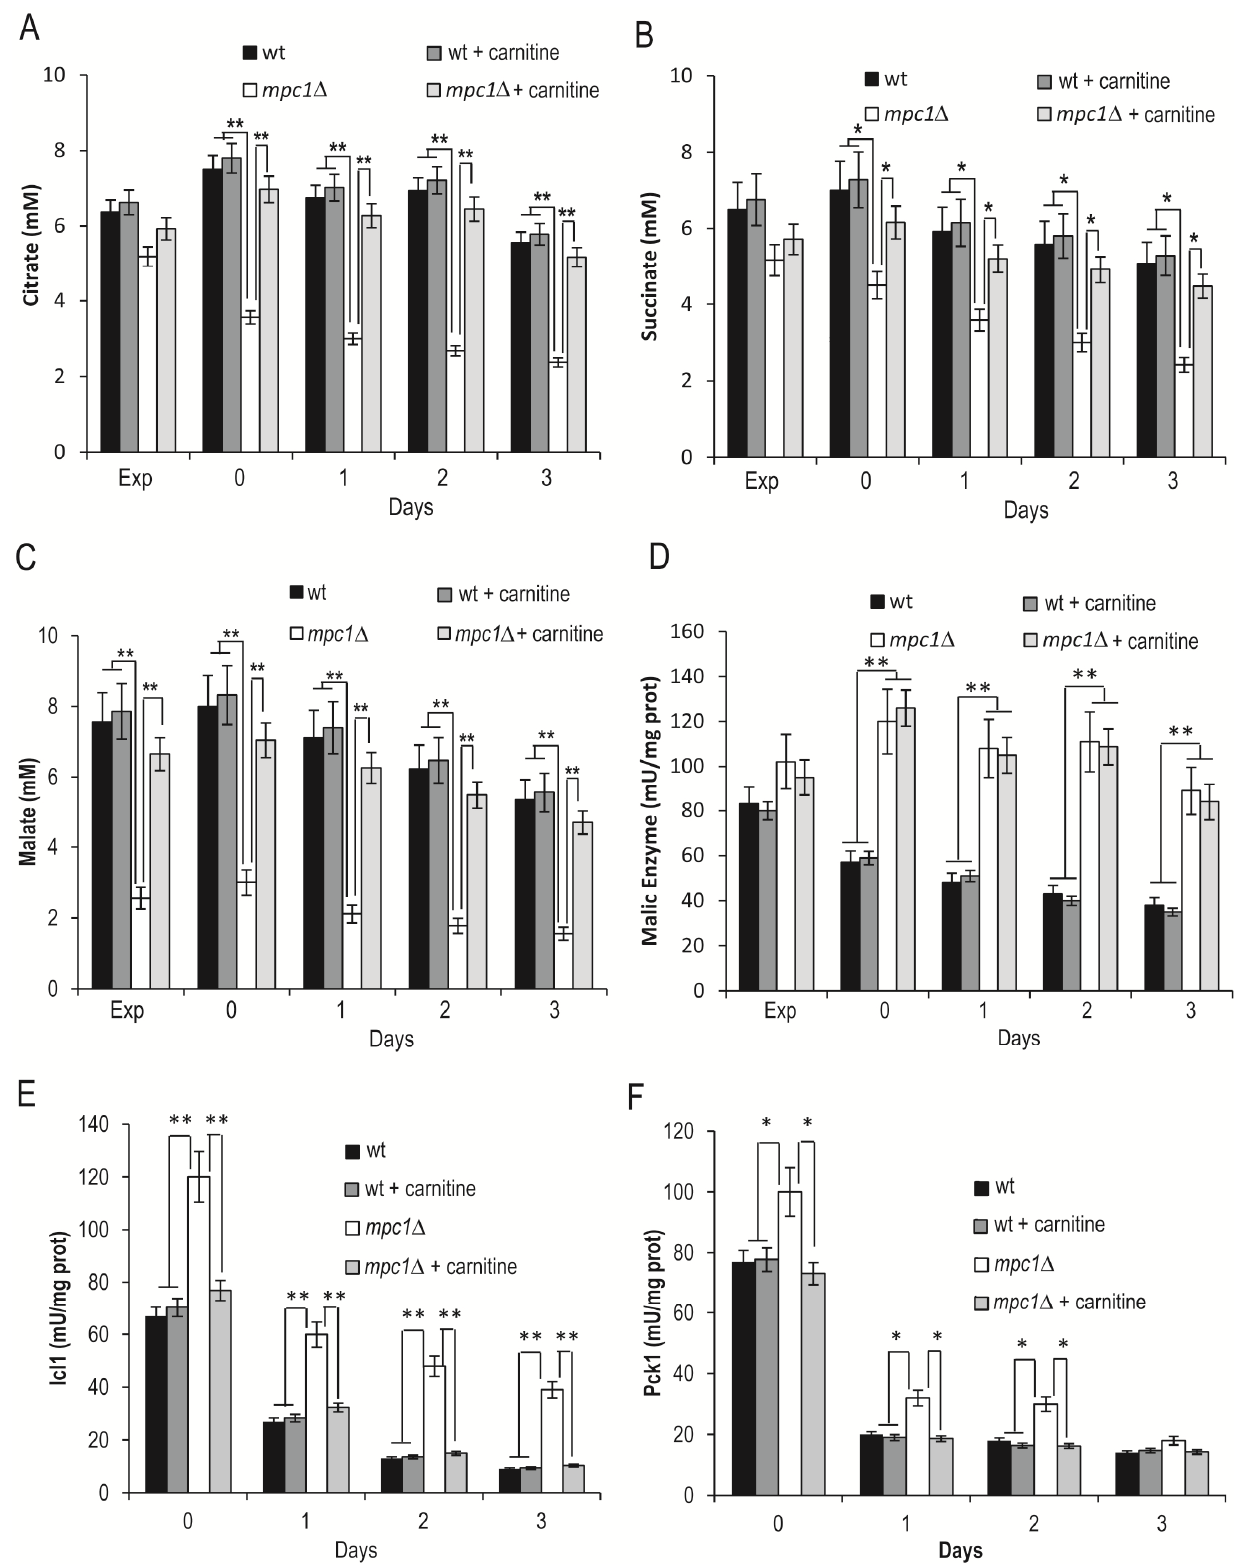
FIGURE 7: Carnitine increases the levels of the TCA cycle intermediates in the mpc1 ∆ mutant. Wt and mpc1Δ cells were grown in minimal medium/2% glucose supplemented with carnitine (10 mg/L) and, at the indicated time points, the concentrations of citrate (A) , succinate (B) and malate (C) were measured together with Mae1 (D) , Icl1 (E) and Pck1 (F) enzymatic activities. Day 0, diauxic shift. Data refer to mean values determined in three independent experiments. SD is indicated. * P ≤ 0.05 and ** P ≤